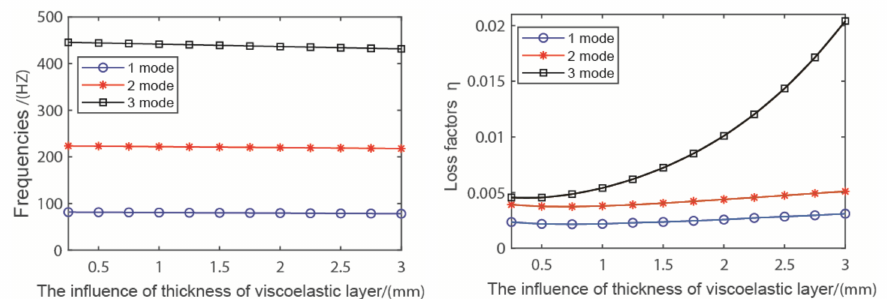
Figure 7. The influence of the thickness of the viscoelastic